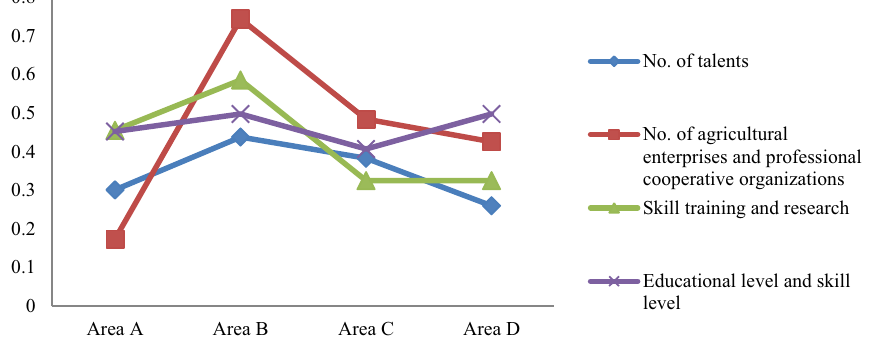
Fig. 1 Changes of the indicators under basic condition element vs. areas